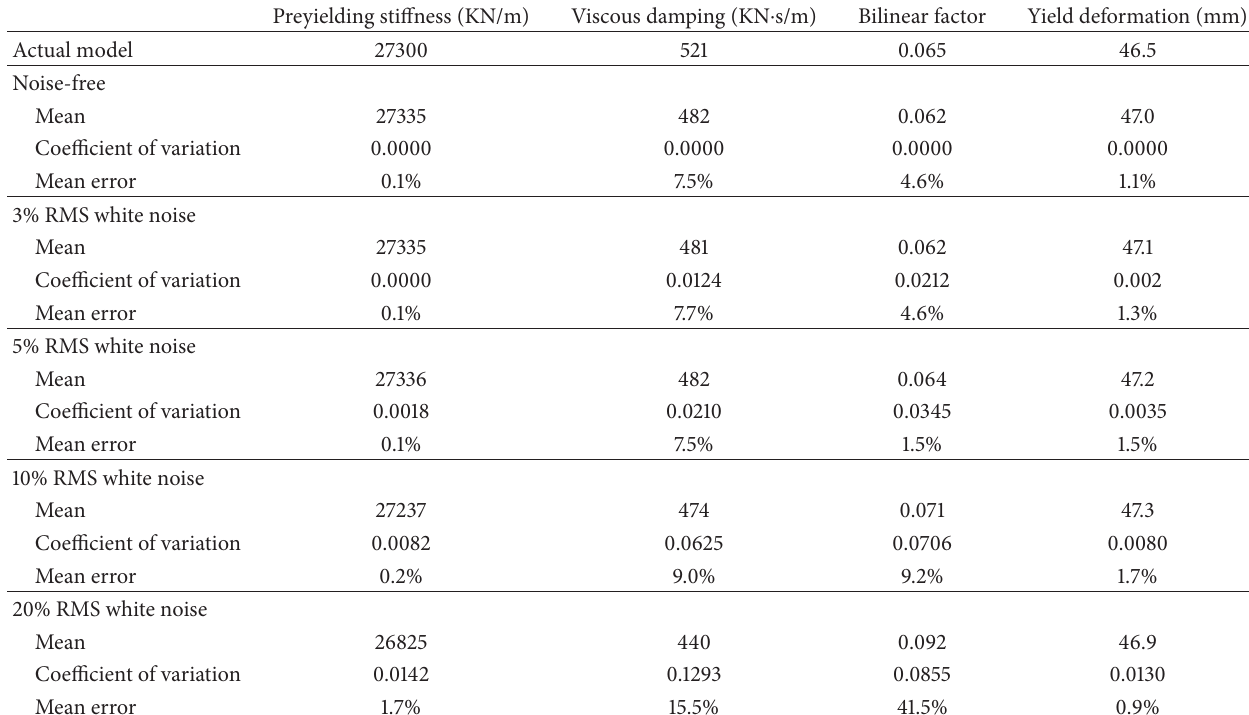
Table 5: Statistical summary of estimated system parameters for 100 Monte-Carlo runs (threshold =